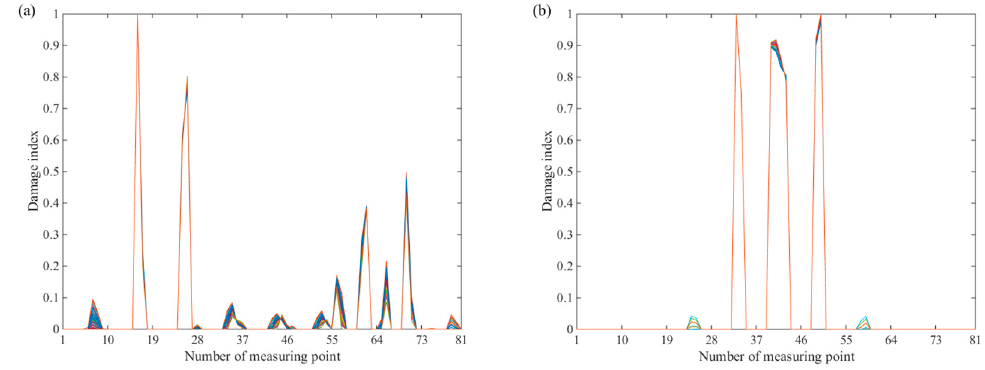
Figure 2. Damage index at the number of measuring points: ( a ) damage case 1 and ( b ) damage case 2. (2) The simplified construction method of